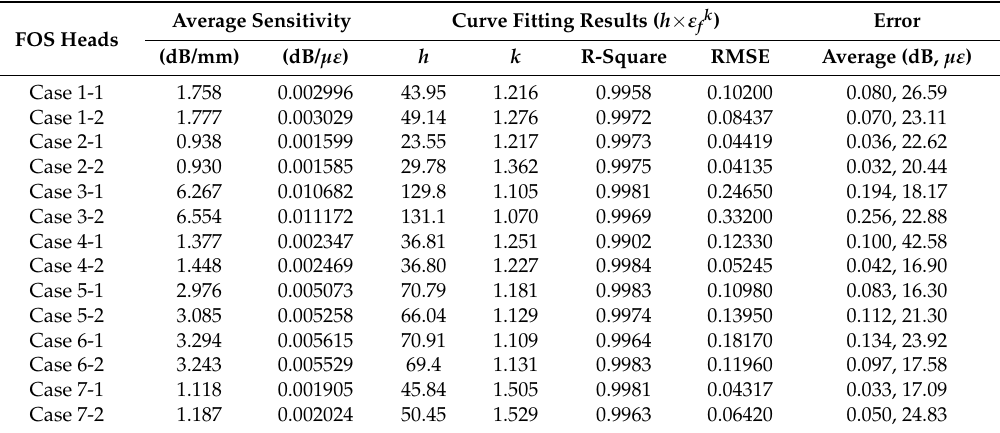
measurement target. Table 3. Measurement results of three-point flexural Table 3. Measurement results of three-point flexural test.